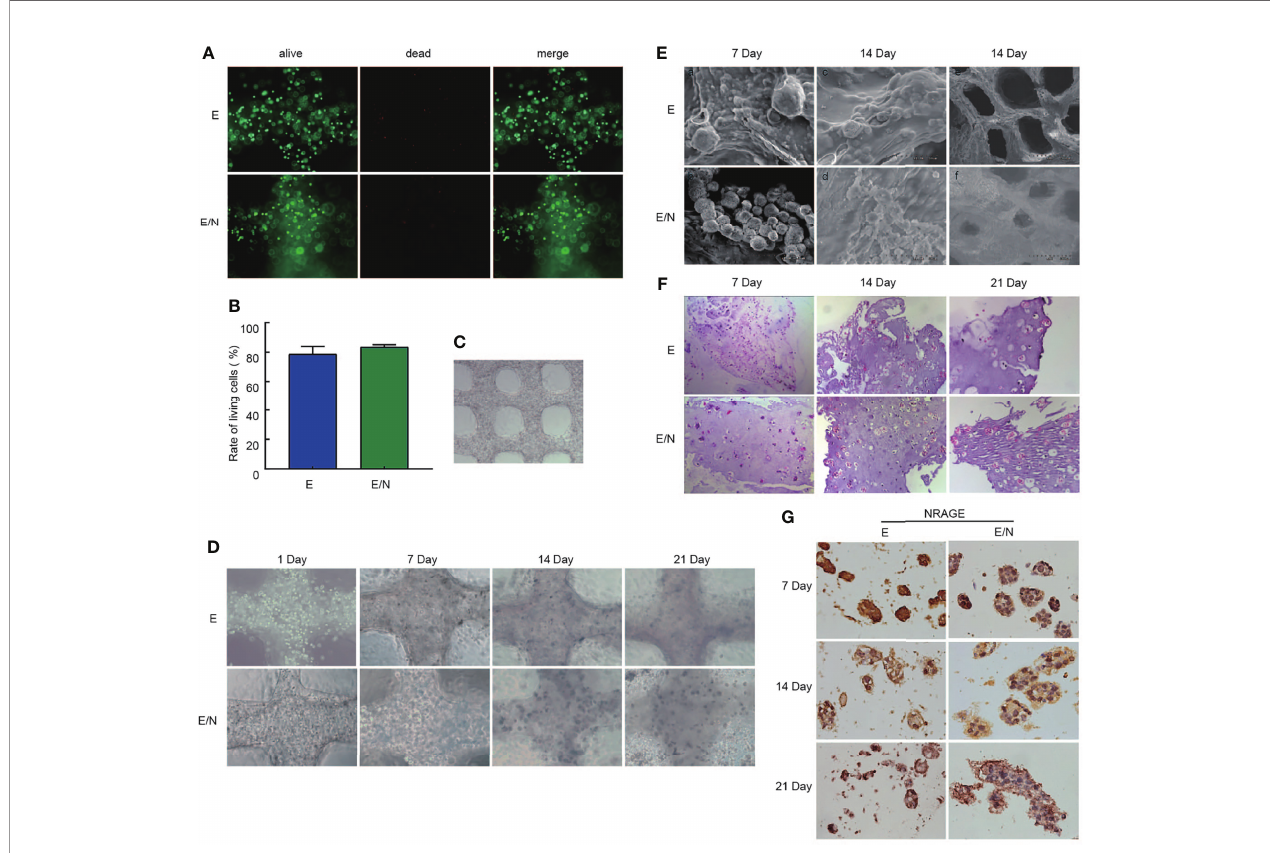
FIGURE 4 | 3D bioprinted ESCC cell-laden system cultured in vitro . (A) Live/dead staining for cell viability after printing, where live cells are stained in green and dead cells in red. (B) Cell viability of E and E/N cells after printing. (C) 3D bioprinted E and E/N cells at day 1 of culturing. (D) optical microscopy images. (E) SEM images. (F) Hematoxylin – eosin staining: 3D bioprinted E and E/N cells cultured in vitro for 7, 14, and 21 d (G) Immunohistochemistry of 3D bioprinted E and E/N cells: NRAGE expression at 7, 14, and 21 d in culture. Scale bars: (A, D, F) 100 m m; (C) 200 m m; (E) a – d 50 m m, e – f 500 m m; (G) 50 m